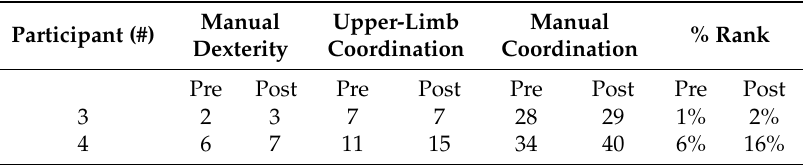
Table 3. The pre ‐ and post ‐ intervention BOT ‐ 2 standard scores for Participants 3 and 4. Table 3. The pre- and post-intervention BOT-2 standard scores for Participants 3 and 4.